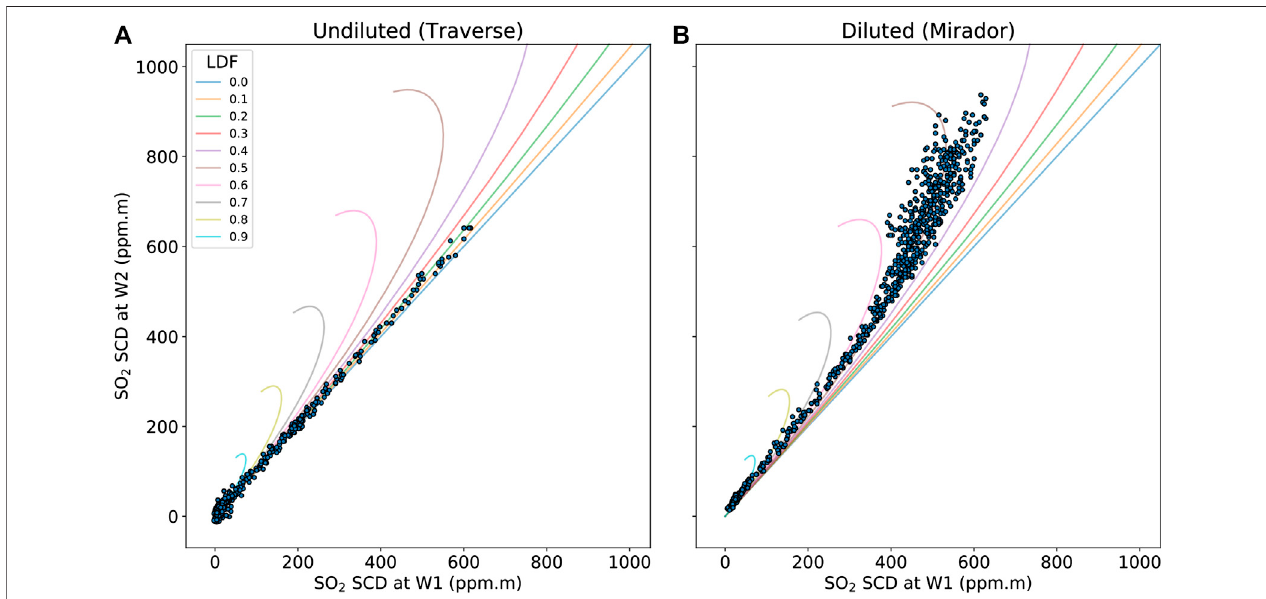
FIGURE 6 | Spectra, taken during the road traverses in panel (A) , and from Mirador in panels (B) , are analyzed using two different wavebands W1 (306 – 316 nm) and W2 (312 – 322 nm). The results are then compared to the model output to estimate the light dilution factor occurring, with LDFs displayed every 0.1 (solid lines).